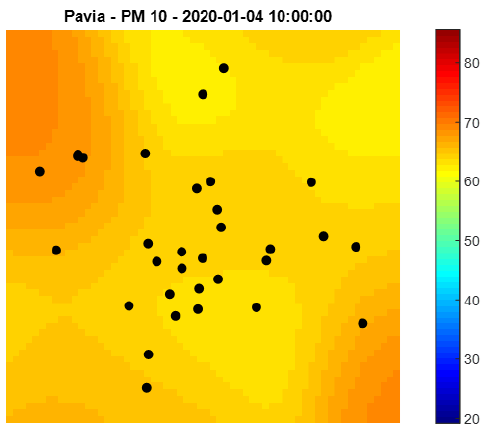
Figure 13. The interpolated continuous model for PM10; day selected in January 4th, 2020 and time shown is 10:00 AM Continuous maps are obtained by gaussian-kernel interpolation applied to discrete measurements shown in Figure 10. It’s